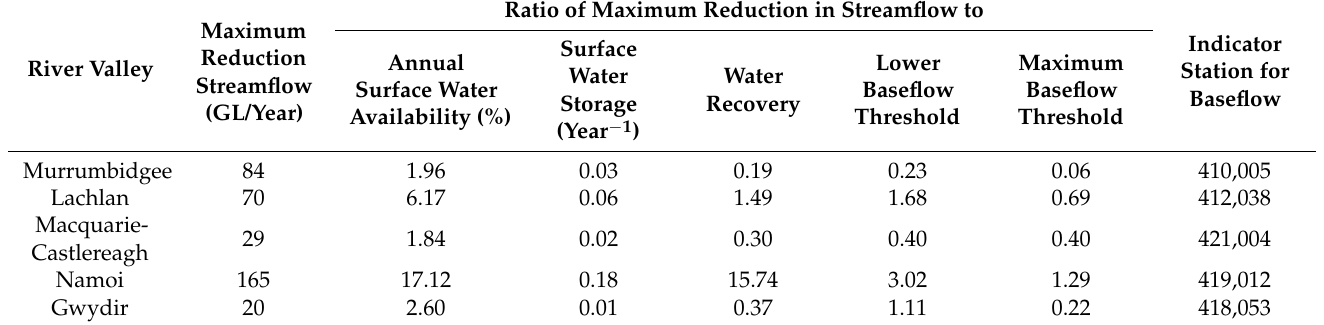
Table 5. Risk indicators for each valley not including Victorian or South Australian rivers. The maximum aggregate impact of priority units is shown as well as the ratio of this to annual surface water availability [21], surface water storage [89], surface water recovery targets [90], and baseflow thresholds [91–96] as determined by most relevant gauging station in that